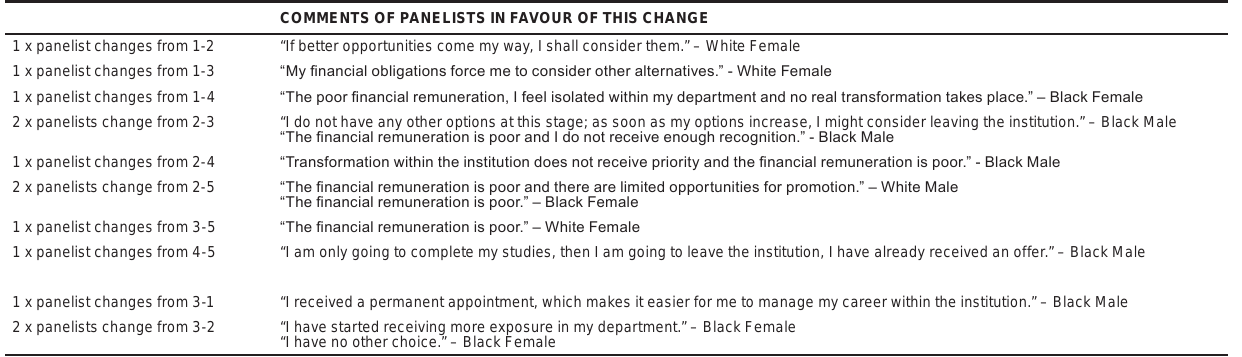
table 4 Comments of panelists where changes occured between rounds one and two